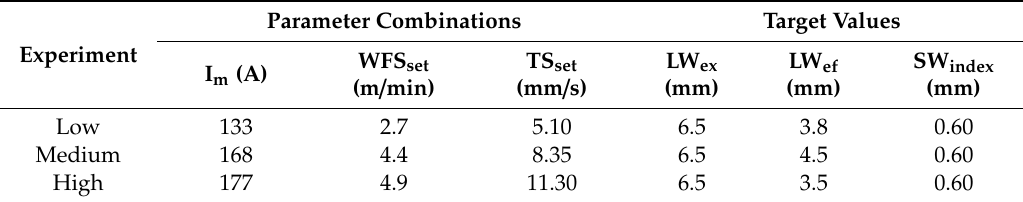
Figure 22. Selection of parameters based on target LW for validation using external LW operational map (macrograph measured). Table 9. Parametric sets for experiments used in validation of the working envelopes.